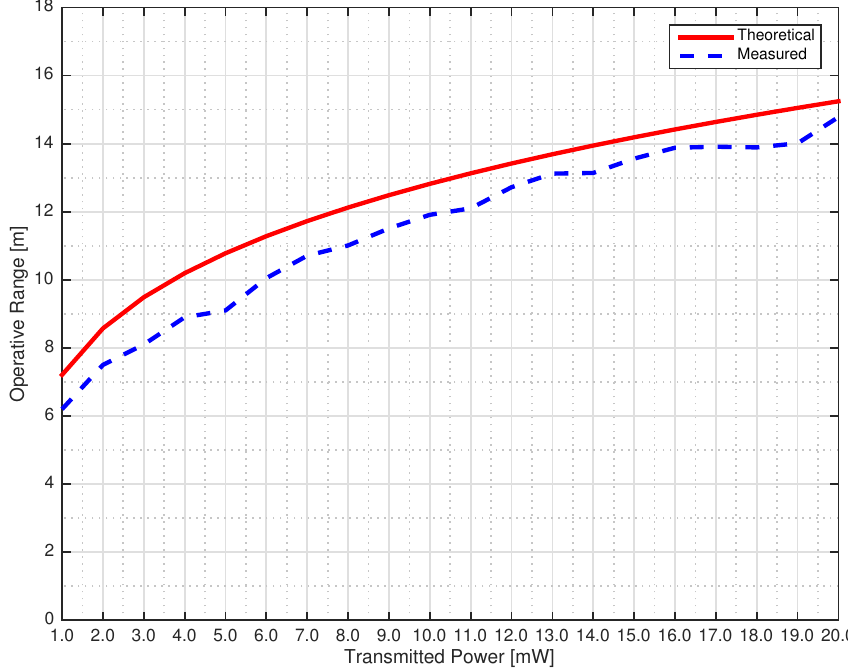
Figure 6. Operative range vs. transmitted power. Continuous red line, theoretical; dotted blue line, experimental.